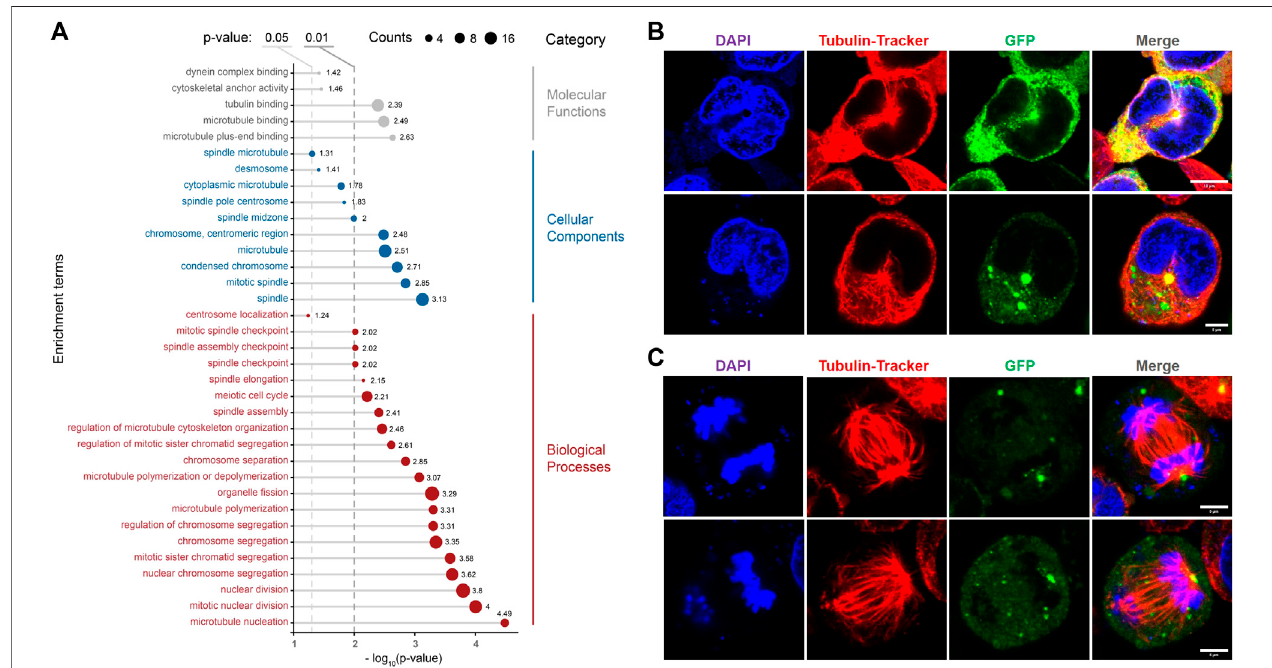
FIGURE 6 | Effects of RfA1 on microtubule and mitosis. (A) GO annotation of DEGs between pEGFP-C1 transfected cells and pEGFP-C1-RfA1 transfected cells. Genes are converted to ENTREZ ID and R package clusterPro fi ler is used to perform GO annotation. Biological Process, Cellular Component and Molecular Function termsareshowninthe fi gure,andthethresholdwassetasthe p -value < 0.05. (B) RfA1co-localizationwithmicrotubulenetworksinthecenter,ininterphasecells.Nuclei and microtubule are stained with DAPI (blue) and Tubulin-Tracker Red (Beyotime), RfA1 are indicated by tandem EGFP (green), scale bars = 10 μ M. (C) RfA1 located at the spindle center, in late mitosis cells. Nuclei and microtubule are stained with DAPI (blue) and Tubulin-Tracker Red (Beyotime), RfA1 is indicated by tandem EGFP (green), scale bars = 5 μ M (see Supplementary Movies S3, S4 ).